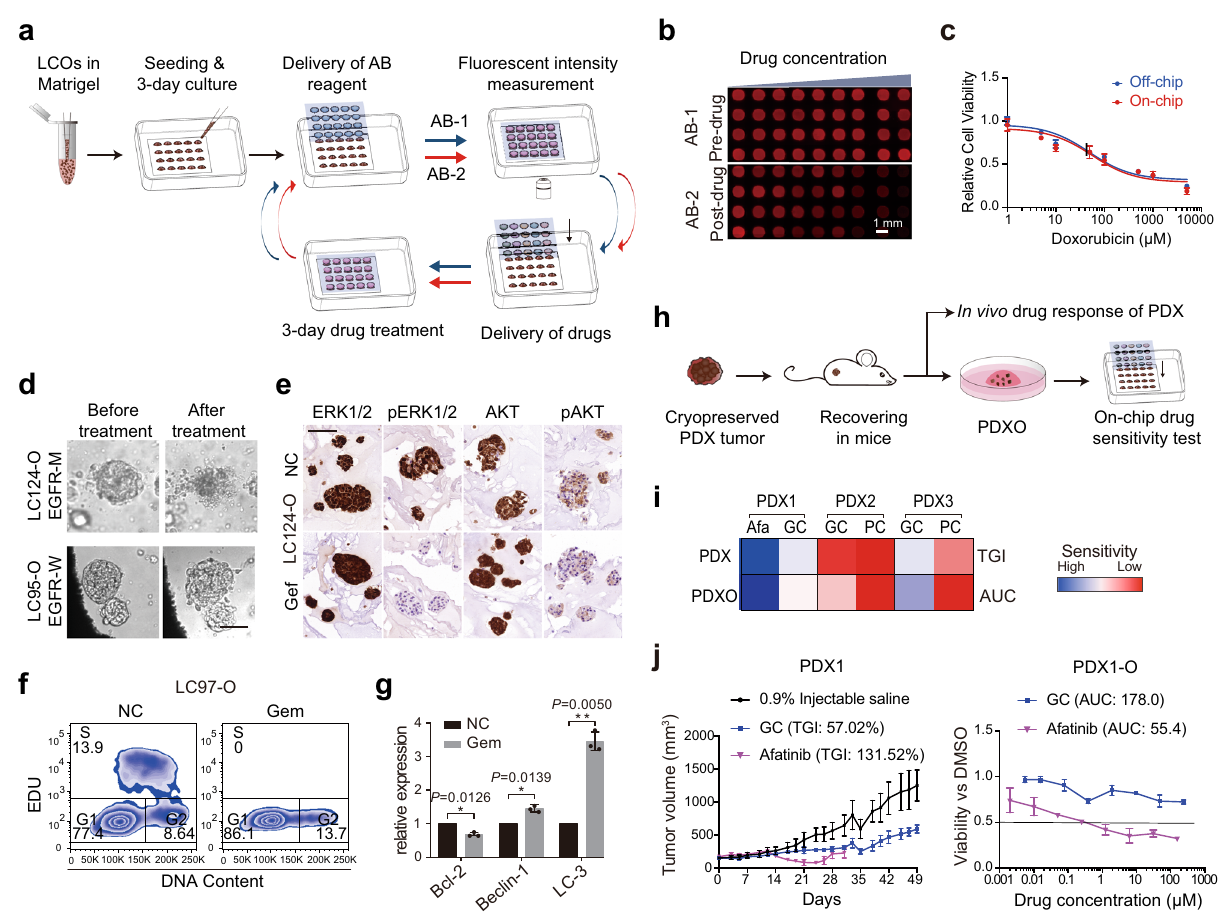
Fig. 4 Validation of the organoid-based, 1-week drug sensitivity test on the InSMAR-chip. a Diagram illustrating the procedure of the one-week drug sensitivity test performed on the InSMAR-chip. AB-1: cell viability test with alamaBlue TM before drug treatment; AB-2: cell viability test after drug treatment. b Mosaic of the fl uorescent images of the microwell array showing the fl uorescent signals of the microwells before (upper) and after (lower) the drug treatment. Scale bar, 1 mm. c Overlapped fi tted dose – response curves measured on the InSMAR-chip (on-chip) and in the microplate (off-chip) ( n = 4 biologically independent cells, data are presented as mean ± SD). d Bright- fi eld images of the LCOs treated with ge fi tinib, demonstrating the organoids with the EGFR P.G719A mutation were killed while the organoids with the wild-type EGFR kept growing under the same condition. Scale bar, 100 µ m. The experiments are repeated three times. e Images of the immunohistochemical staining indicated that ge fi tinib inhibits the ERK 1/2 and the AKT activities downstream of EGFR. NC, untreated, Gef ge fi tinib treated. Scale bar, 200 µ m. The experiments are repeated three times. f Cell cycle analysis of LCOs cultured on the InSMAR-chip and treated with gemcitabine, showing the elimination of the cells in the S phase by the drug. g qPCR analysis of LCOs illustrating the variations in gene expressions upon the gemcitabine treatment ( n = 3 independent experiments, two-sided Student ’ s t test, data are presented as mean ± SD). h Diagram of the comparison process of the in vitro drug sensitivity test using the PDX-derived organoids (PDXO) with the PDX- based drug test in mice. i Heat map of the drug effects demonstrating the consistency between the TGI (the tumor growth inhibition) of PDX and the AUC (the area under the dose – response curve) of PDXO. j A representative example (PDX1) illustrating that the on-chip drug sensitivity results of PDXO were in good agreement with the responses of PDX mice ( n = 3 biologically independent animals in the left panel; n = 3 biologically independent LCOs in the right panel, data are presented as mean ±